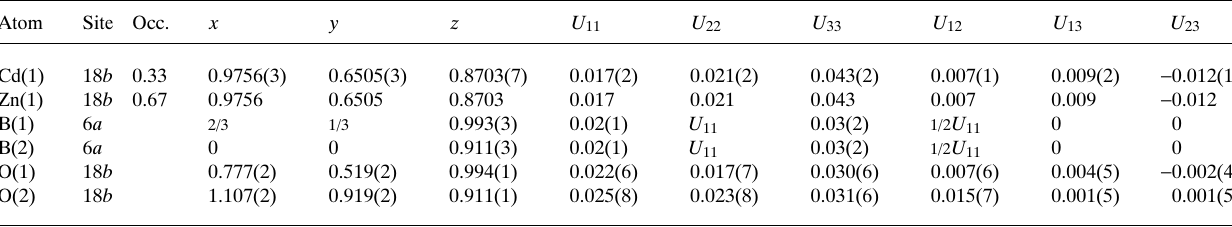
Table 2. Atomic coordinates and displacement parameters (in Å 2 ) . Atom Site